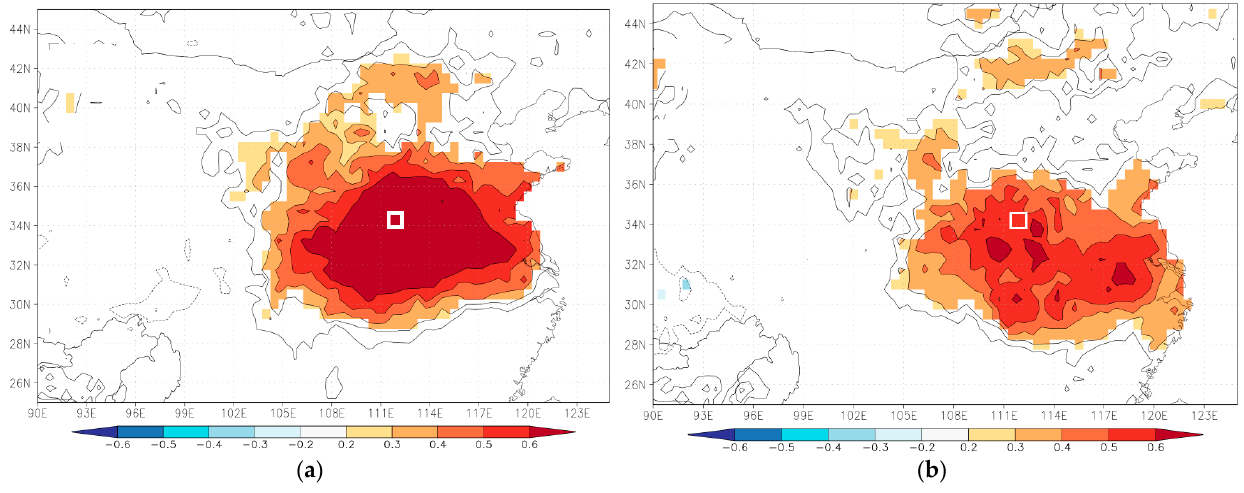
Figure 8. Spatial (90 ° -126 ° E, 25 ° -45 ° N) correlation between actual ( a ) and reconstructed ( b ) scPDSI MJ and scPDSI (1963 – 2016; 4.05 early). The white rectangle represents the reconstructed scPDSI MJ area (33.5 – 34.5 N, 111.5 – 112.5 E).